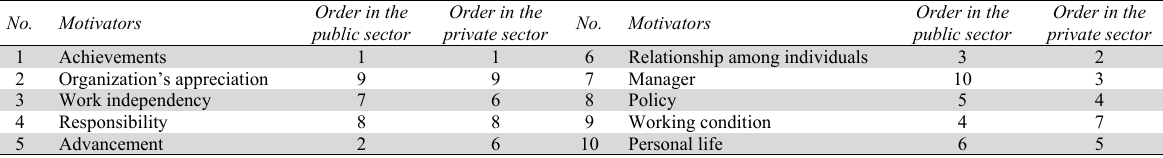
Differences in motivators between the public and private sectors in the study of Azash et al. (2011) No.